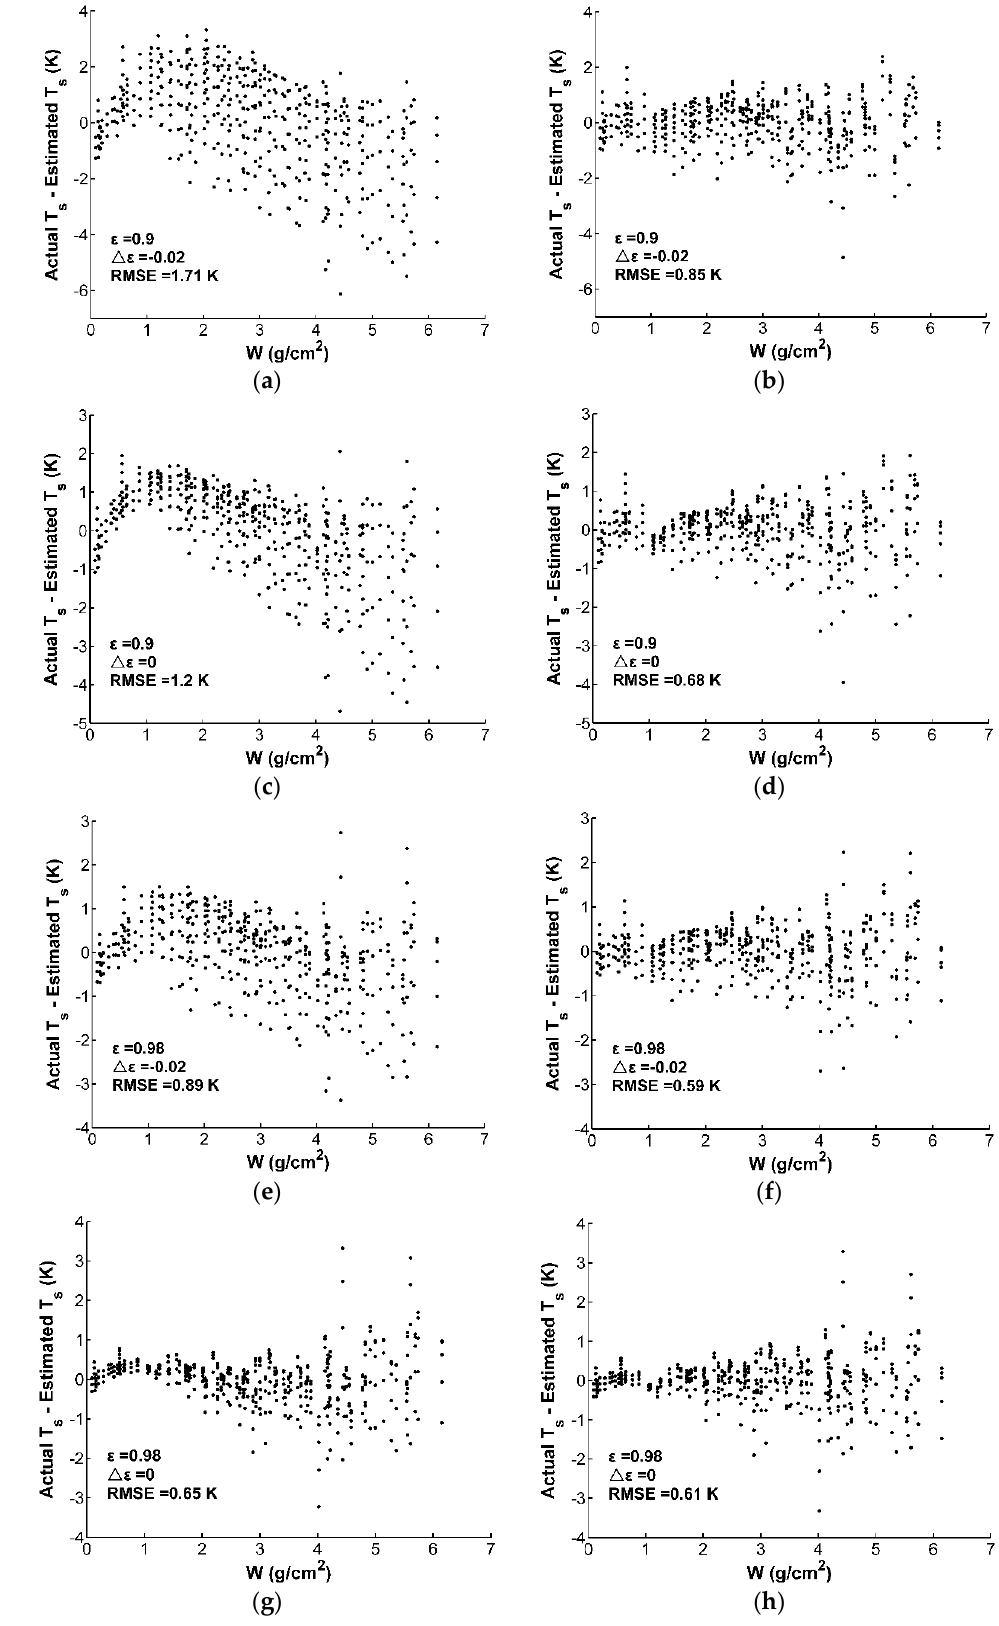
Figure 13. Comparison of the residuals related to Equation (1) ( a , c , e , g ) and Equations (9) and (10) ( b , d , f , h ) for different combinations of channel mean emissivity ( ε ) and channel emissivity difference ( Δε ).